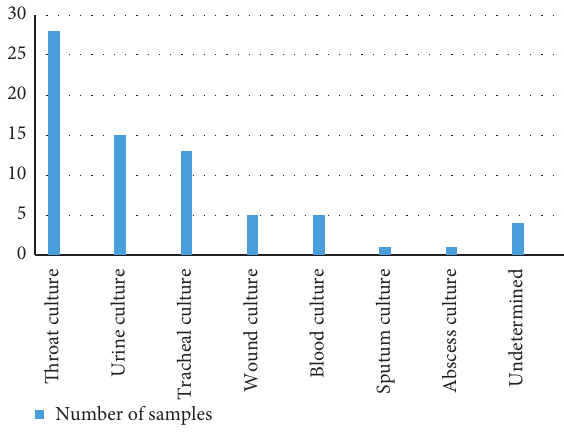
Figure 2: Number of different samples types.